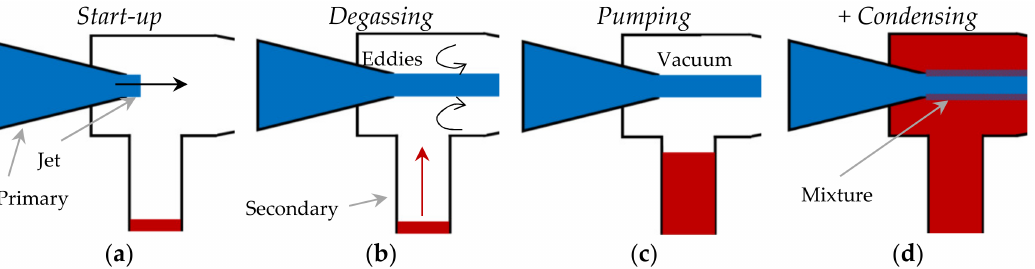
Figure 7. Thermal and mechanical mechanism in eductor. ( a ) Startup ( b ) Degassing ( c ) Pumping ( d )